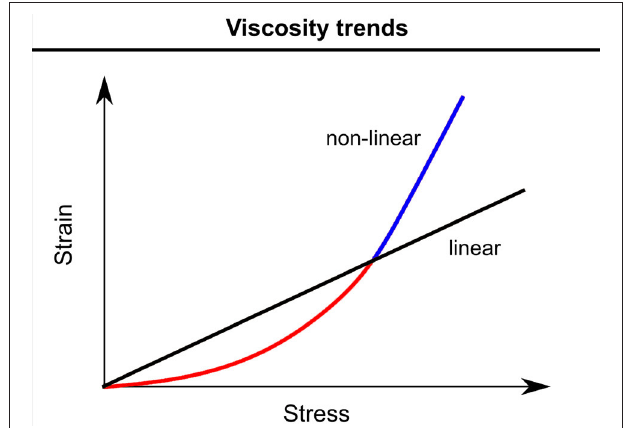
FIGURE 8 | Stress-strain graphs of a linearly viscous medium, assumed in our calculations, and a non-linearly viscous shear-thinning medium, which is a more precise representation of glacier ice, are shown. Negative relief anomalies (blue) are suggested to correspond with areas where the linear approximation overestimates viscosity, at high stress-strain rates, and vice versa